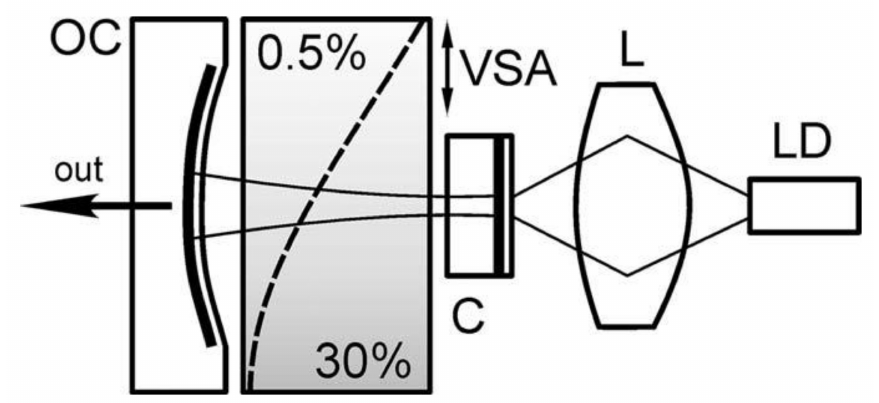
Figure 7. Schematic diagram of the PQS Nd:GdVO 4 self-Raman laser: LD, laser diode; L, focusing lens; C, laser crystal; VSA, saturable absorber with variable transmission; OC, output coupler